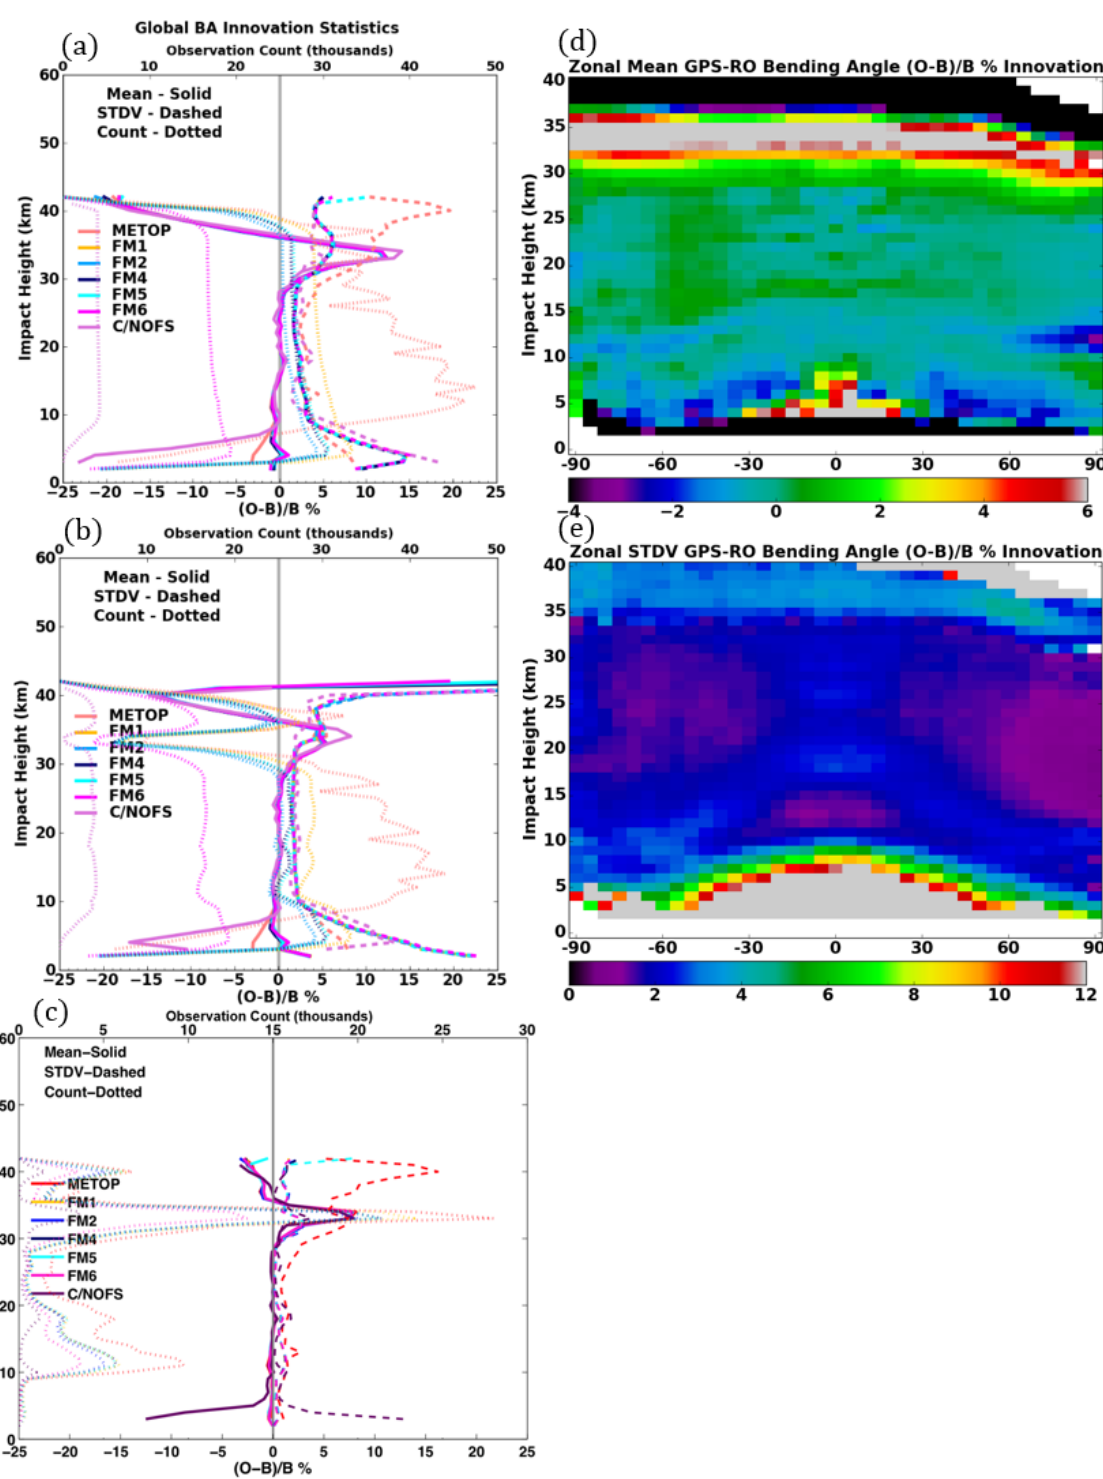
Figure 5. Same as Fig. 3 for the month of November 2012 except for the use of CAM-SE ensemble